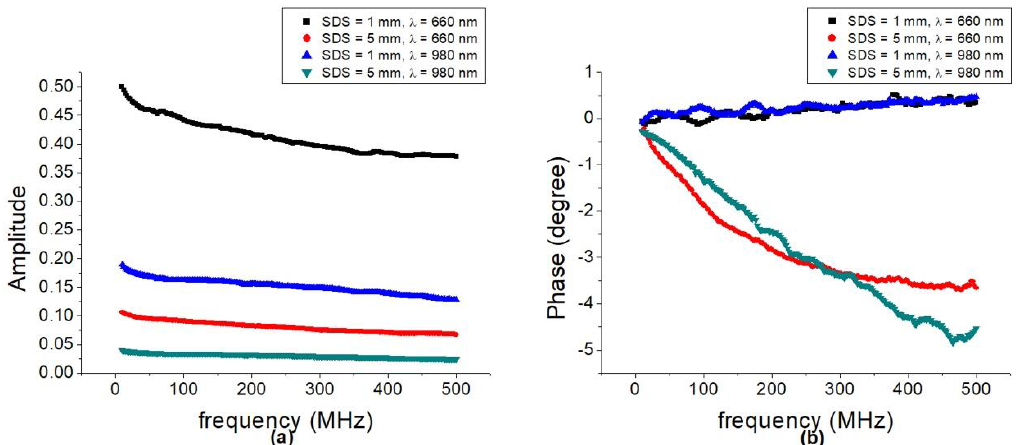
Figure 4. ( a ) Amplitude and ( b ) phase of apples verse the source modulation frequencies generated from different source–detector separations (SDSs) and wavelengths: 1 mm at 660 nm ( ■ ), 5 mm at 660 nm ( ● ), 1 mm at 980 nm ( ▲ ), and 5 mm at 980 nm ( ▲ ).